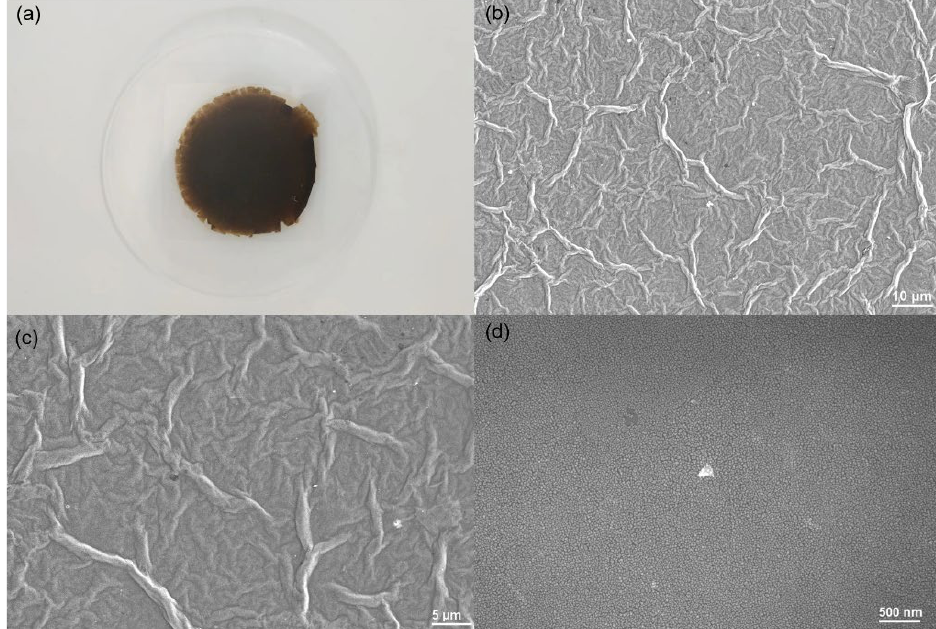
Figure 3. Macroscopic images and SEM images of GO/PNF/AgNP hybrid membranes: ( a ) macroscopic images of GO/PNF/AgNP hybrid membranes. ( b – d ) SEM images of GO/PNF/AgNP hybrid membranes at different magnifications.